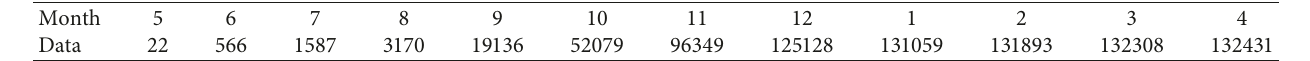
Table 2: Monthly cumulative confirmed data on A/H1N1 outbreaks from May 2009 to April